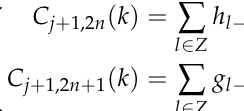
where j and n represent the number of WPD layers and sub-bands, respectively; C j , n denotes the wavelet coefficient sequence of the nth node in the jth layer; C 0,0 is the original signal; and h and g denote the high-pass filter and low-pass filter, respectively. The equation between h and g is given